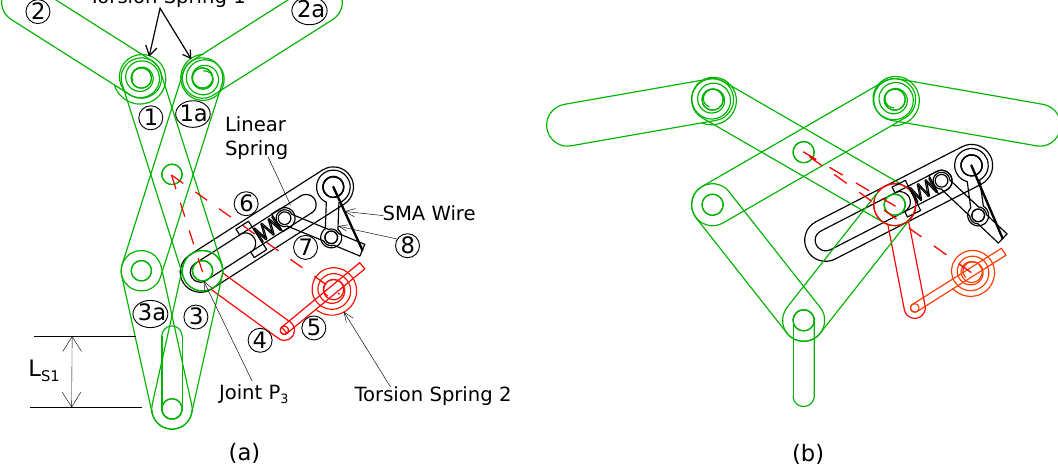
Figure 3. Detailed front view of the anti-slip mechanism ( a ) open position; ( b ) closed